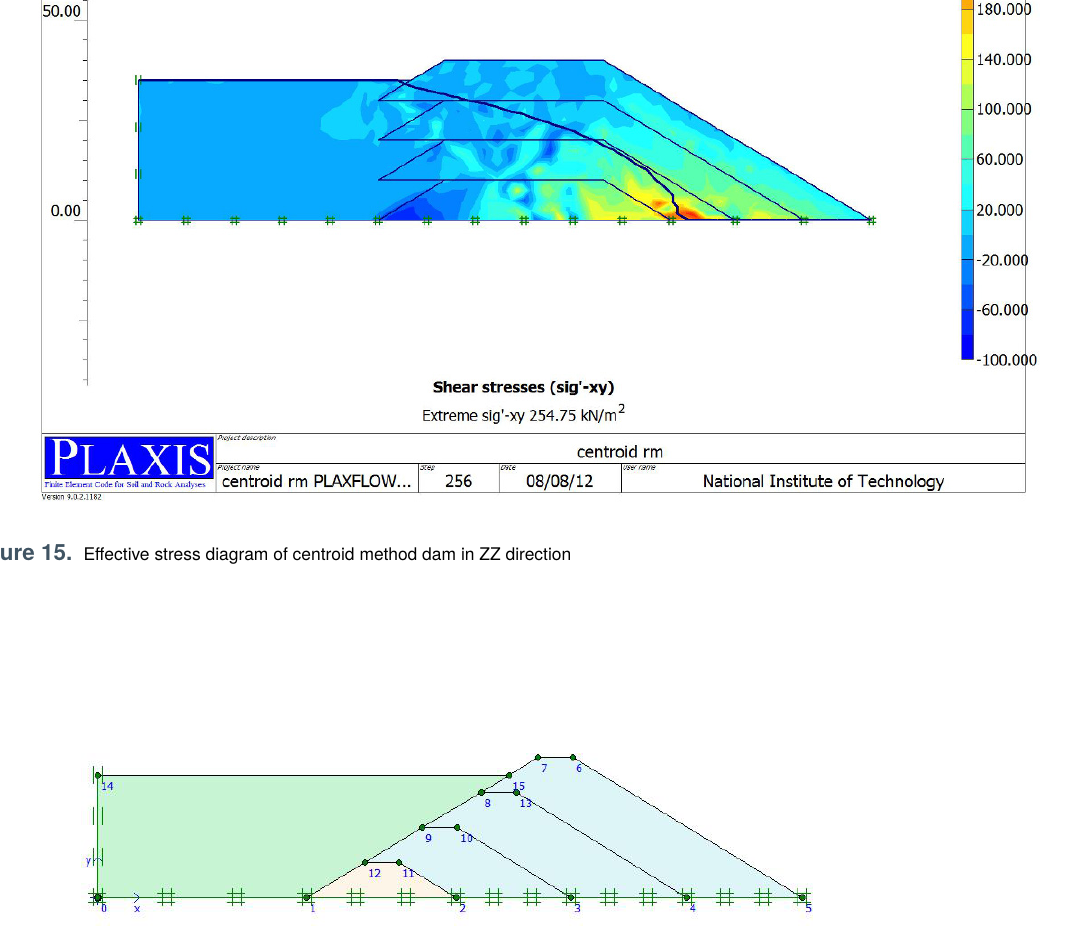
seen that FOS is less compare to upstream method.